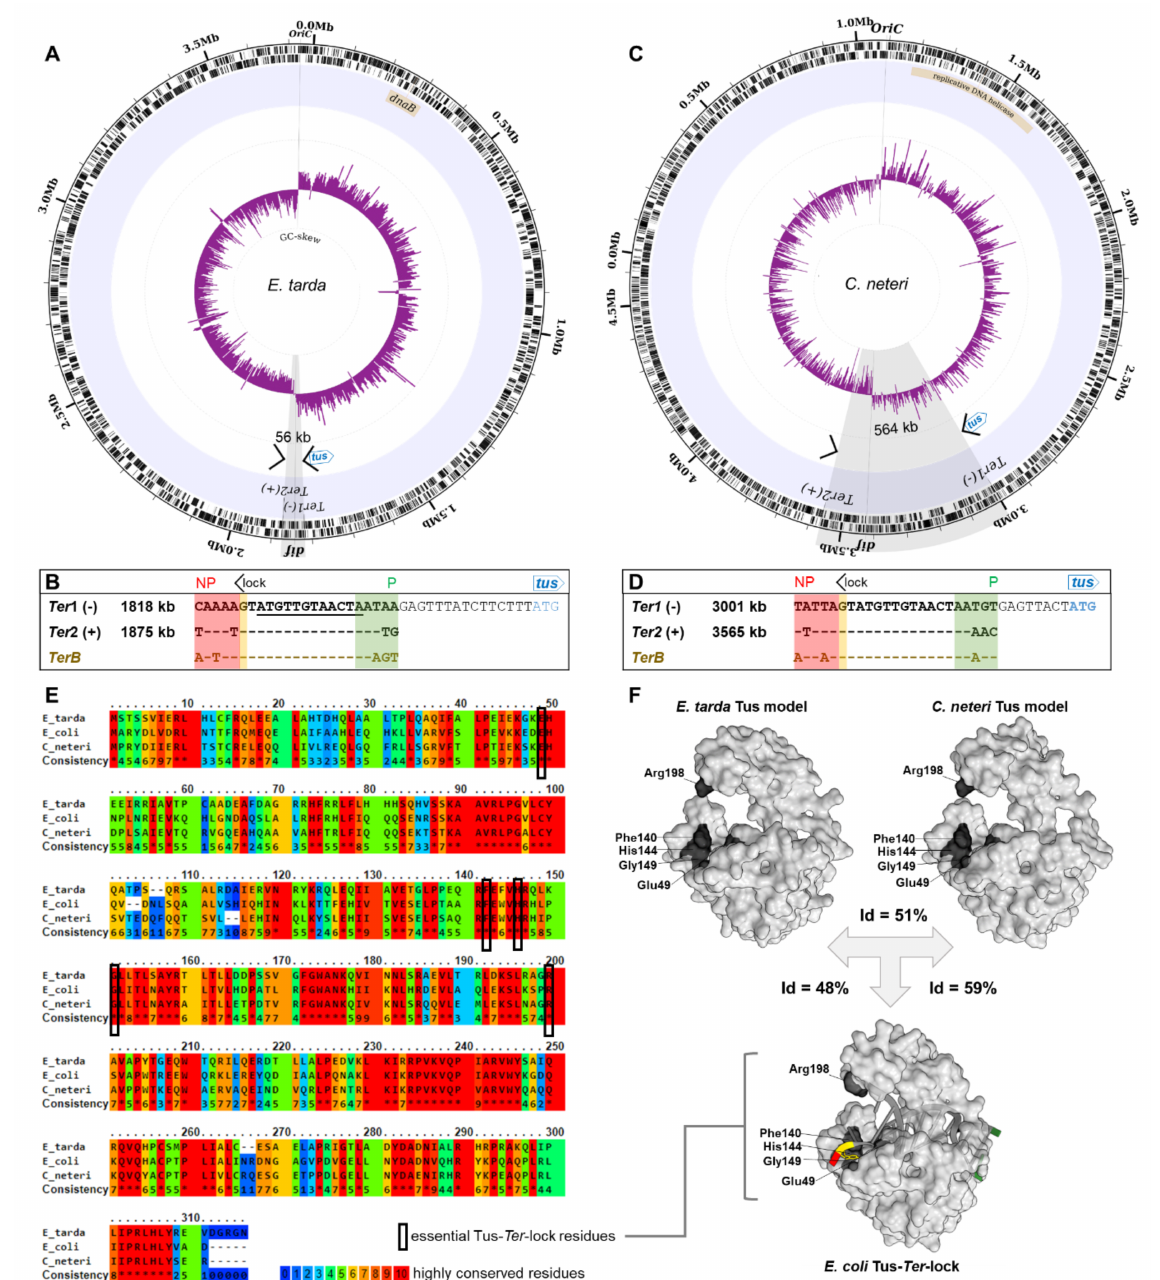
Figure 4. Prototypical type I replication fork trap. ( A ) Circular representation of E. tarda (strain EIB202) chromosome. Illustrated from the outside to the centre of the circle: forward and reverse genes, labelled genomic location of identified Ter sites involved in DNA replication termination, simplified annotation of the termination fork trap utilised, GC-skew over a 5000 bp moving window. The sharp GC-skew switches polarity at the replication origin and between the two identified Ter sites near dif . ( B ) Sequence alignment and genomic locations of the E. tarda Ter sites and TerB from E. coli . Ter1 is located slightly upstream of the start site (ATG) of the tus gene similar to TerB in E. coli. The strictly conserved 12 bp core sequence is underlined and the G(6) base complementary to C(6) is highlighted in yellow. NP: non-permissive face (red), P: permissive face (green). ( C ) Circular representation of C. neteri (strain ND14a) chromosome. ( D ) Sequence alignment and genomic locations of the C. neteri Ter sites and TerB from E. coli . ( E ) Tus protein sequence alignment (PRALINE) with highlighted conserved residues. ( F ) Comparison of the E. coli Tus– Ter –lock complex 3D structure (PDB 2I06) and the modelled structure of E. tarda and C. neteri Tus proteins using SWISS-MODEL. The essential amino acid residues in the cytosine binding pocket are indicated. The theoretical isoelectric points of E. coli , E. tarda and C. neteri Tus are 9.57, 9.67 and 9.31,